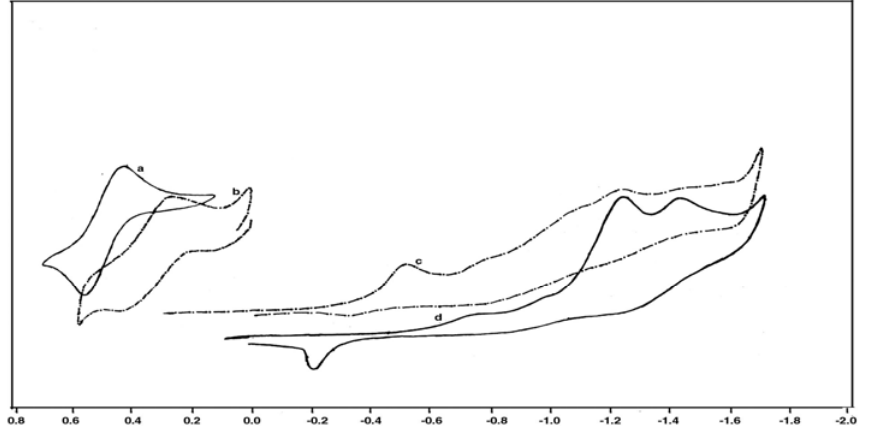
Cl (b) [Fe(BMOT)(H 2 2